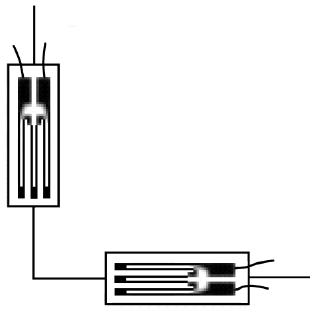
Figure 8. Strain gauge amplifier. The connection diagram of the sensors is shown in Figure 9.